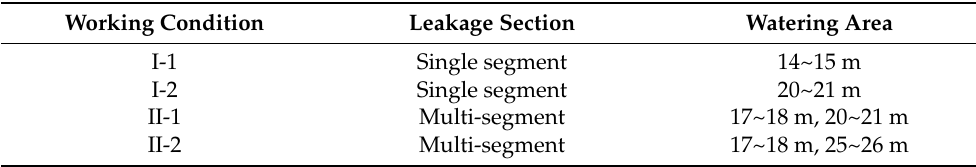
Table 2. Test conditions of abnormal constant temperature